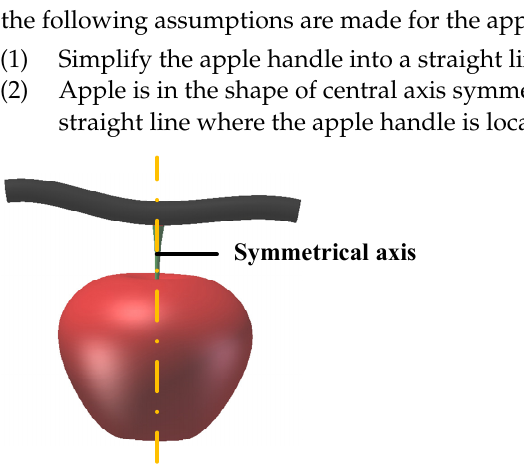
Figure 9. Apple three-dimensional model map.